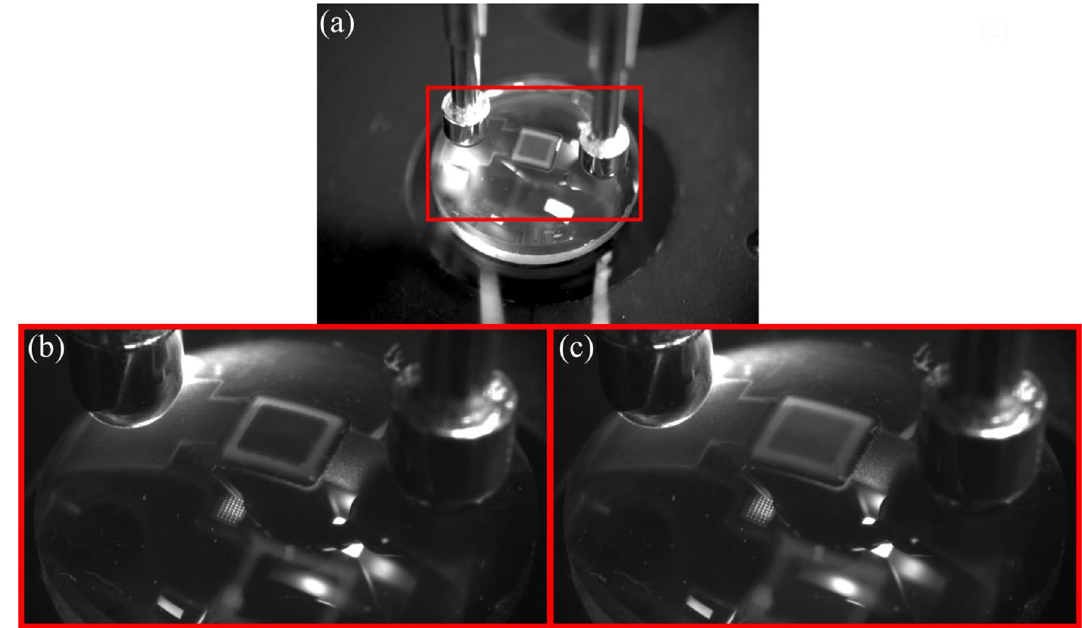
Figure 9. ( a ) Device structure printed onto a 9.5 mm diameter 10 mm focal length lens; ( b ) in the powered, transparent state; ( c ) in the scattering